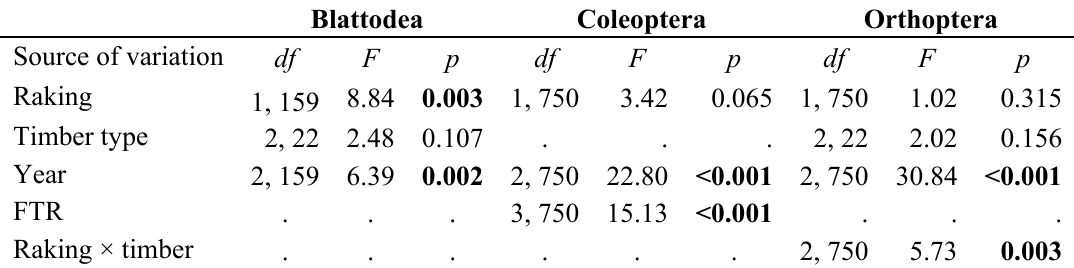
Table 2. ANOVA table for the most parsimonious model explaining the effects of pine straw raking on terrestrial arthropod occurrence based on significant log-likelihood ratio tests (LLRT < 0.05); fixed effects (the source of variation), degrees of freedom ( df ), F -ratio ( F ), and significance levels for the main effects and interactions including raking (pine straw intact or raked), timber species (loblolly, slash or longleaf pine), year (2008, 2009, or 2010), and finer taxonomic resolution (FTR); significant effects are in bold. Blattodea Coleoptera Orthoptera